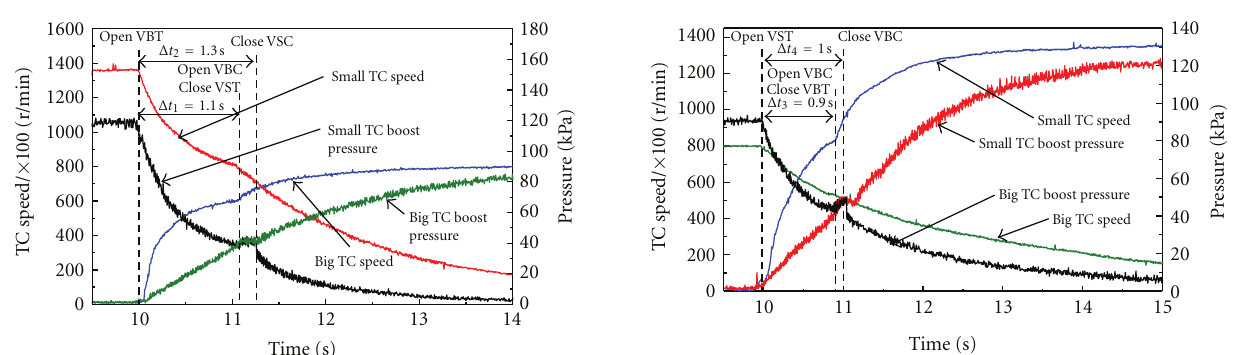
Figure 5: Process from the small TC to the big TC with Δ t 1 = 1 . 1 s and Δ t 2 = 1 . 3 s.